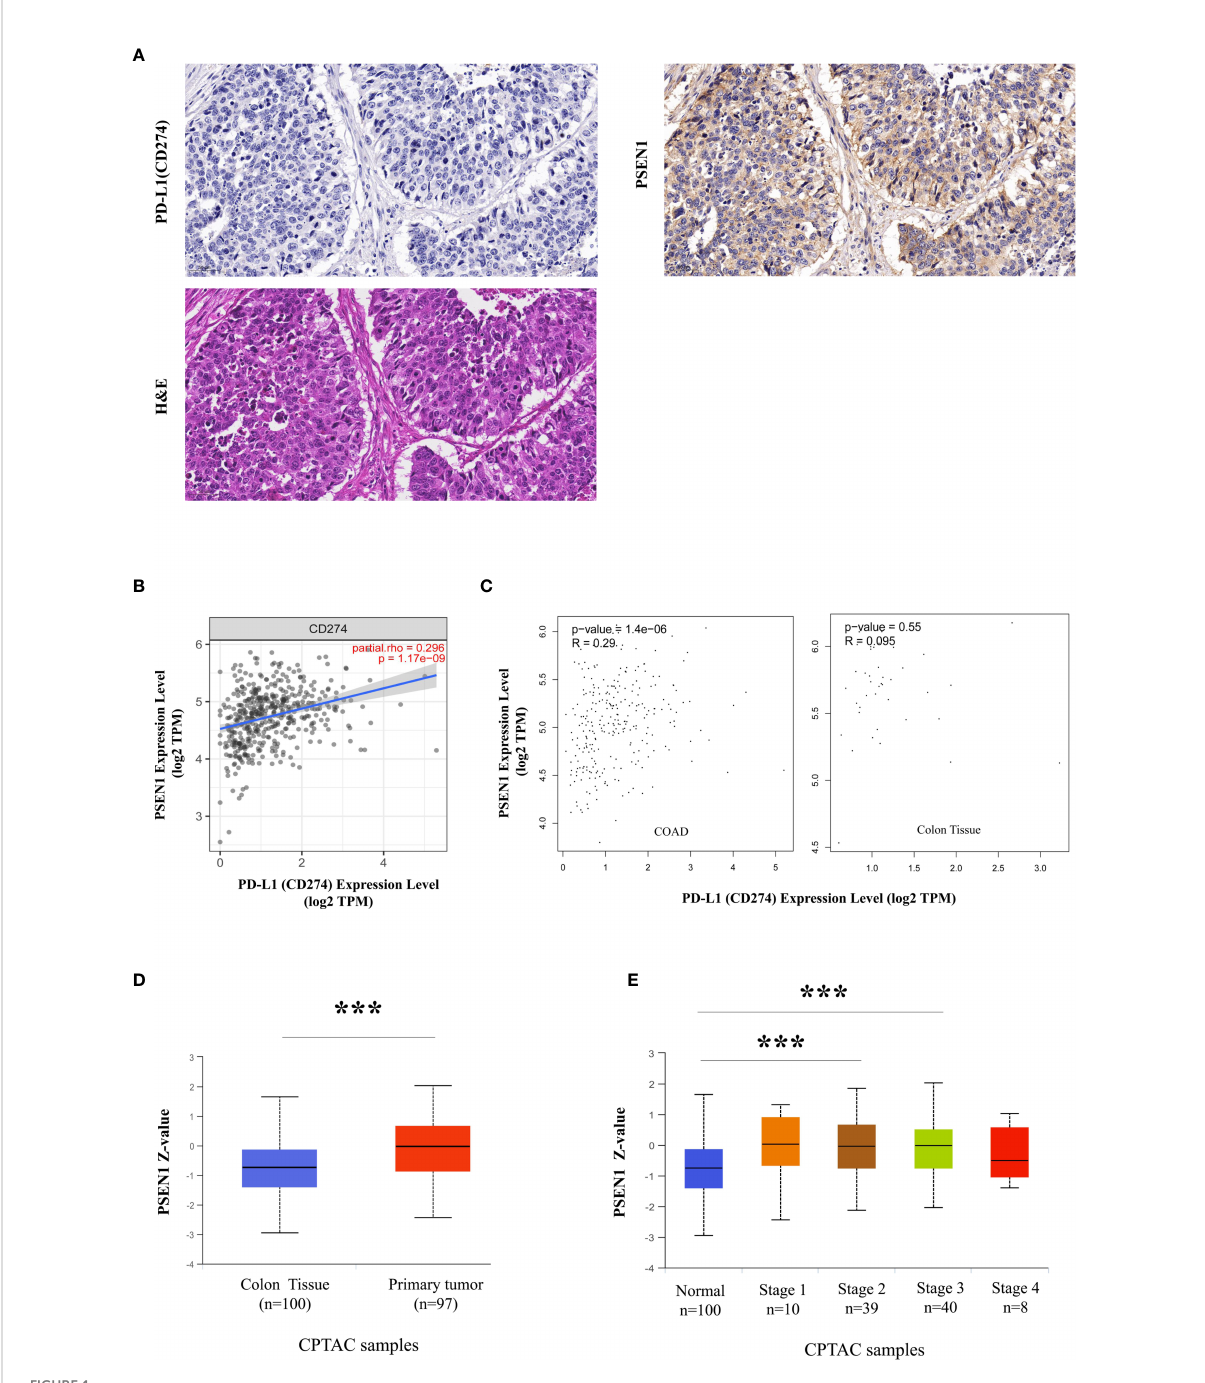
FIGURE 1 A potential protolytic cleavage of PD-L1 engaged by PSEN1. (A) Immunohistochemical images of PD-L1 (CD274) (upper left) and PSEN1 (upper right) expression on human primary colon adenocarcinoma (COAD) as well as the corresponding H&E staining (lower). A zoom scale =50 m m. (B) The correlation between PSEN1 and PD-L1 (CD274) in COAD examined by TIMER2. (C) The correlations between PSEN1 and PD-L1 (CD274) in COAD samples as well as normal colon tissues explored by GEPIA. Levels of the mRNA expression were normalized in Log2 TPM, and the corresponding correlation coef fi cients and signi fi cance were indicated. (D) PSEN1 protein expression levels analyzed by UALCAN, box plots showing the levels of PSEN1 in normal (n = 100) and primary COAD samples (n = 97). (E) The protein levels of PSEN1 against colon cancer stages analyzed by UALCAN. Stage I: T1 or T2 N0 M0; Stage II – T3 or T4 N0 M0; Stage III – Tx N1 or N2 M0; Stage IV – Tx Nx M1. The protein expression levels were log2 normalized in Z-values, and the signi fi cance was indicated with the symbol (*** P <